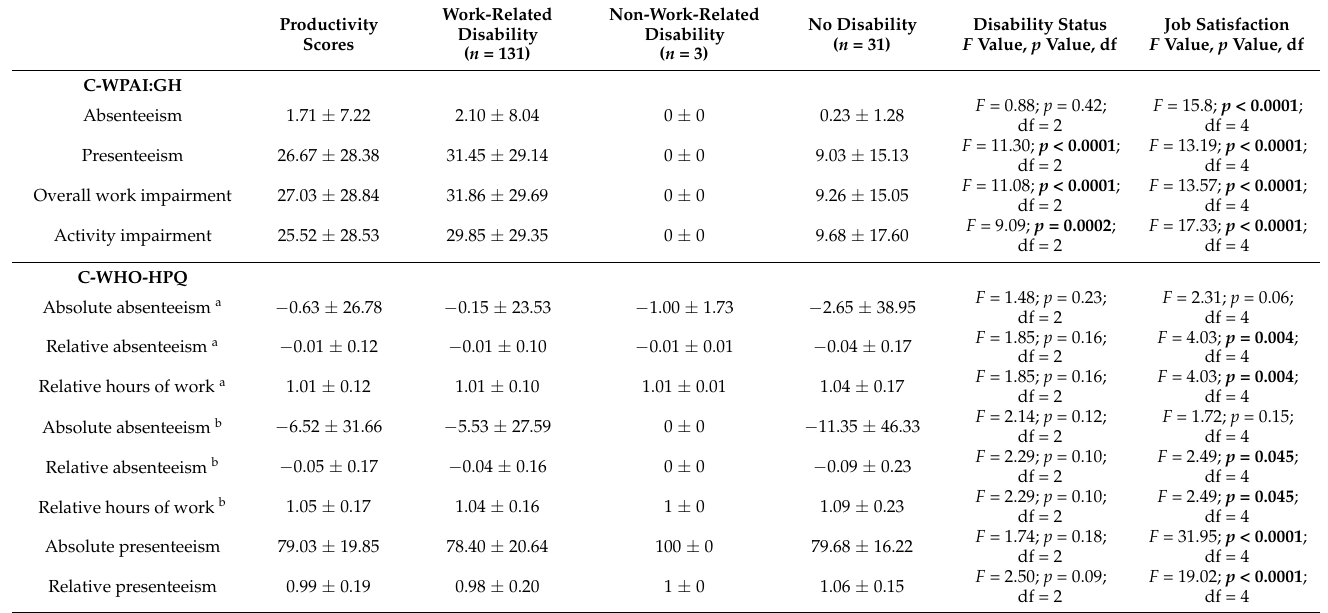
Table 3. Associations of the C-WPAI:GH and C-WHO-HPQ with disability status and job satisfaction (mean ± standard